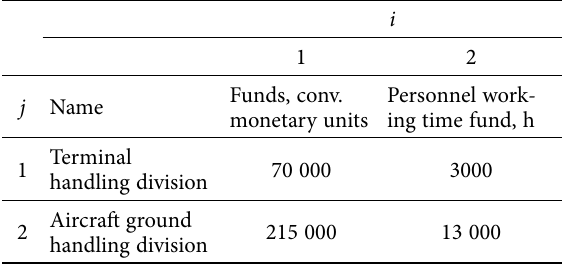
Table 1. Input data for the experimental calculation (all data are privided into one calendar month)